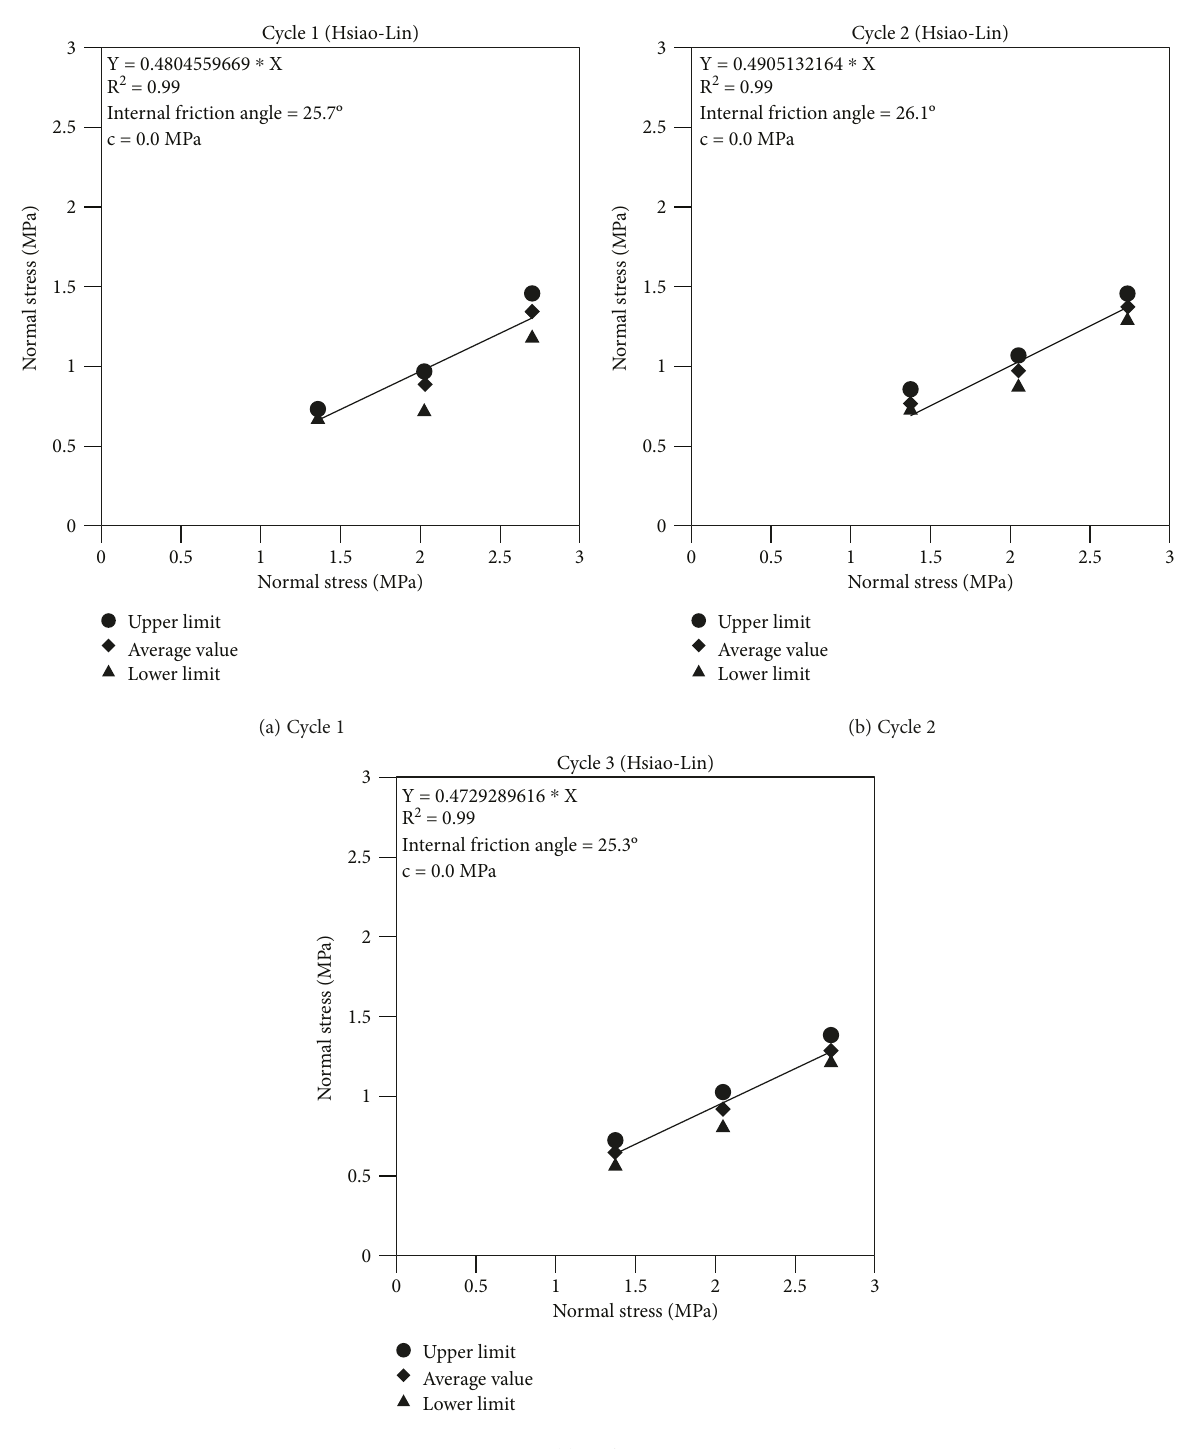
Figure 10: Failure criteria of the sliding